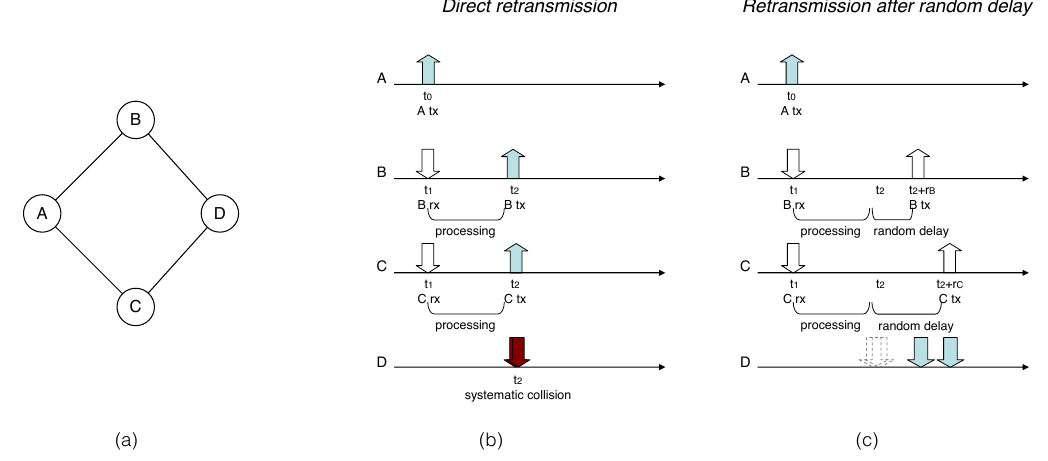
Figure 1. Timeline for packet flooding from A : ( a ) Network topology; ( b )With direct retransmission by B and C ; ( c ) With retransmission by B and C after a random delay. The network topology contains four routers { A, B, C, D } and four bidirectional links { AB, AC, BD, CD }